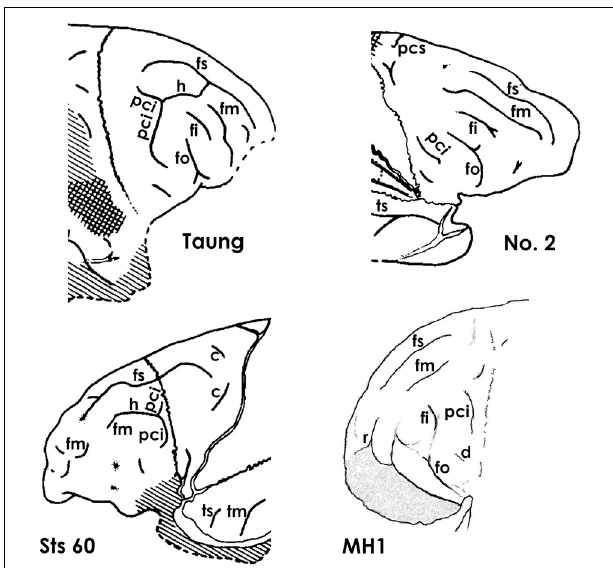
FIGURE 5 | The superior and middle frontal sulcus in Australopithecus endocasts. The middle frontal sulcus ( fm ) of MH1 ( Australopithecus sediba ) is identified here because (1) of its relationship to r (not identified by Carlson et al., 2011), (2) it does not appear to have been derived from (or proximal to) pci (which fi always is, Connolly, 1950), and (3) it courses approximately in the middle of the prefrontal cortex (hence its name). Taung, No. 2, and Sts 60 are endocasts from Australopithecus africanus . Note that all four australopithecines have separate branches of fm , which are rare in ape brains but typical of human brains, and that, in all four, fm is lateral to a long superior frontal sulcus ( fs ). Identifications of sulci: tm , middle temporal; ts , superior temporal; see legend to Figure 4 for other sulcal abbreviations. All illustrations except for MH1 are reproduced from Falk (1980). The identification of fi in Taung and No. 2 departs from Falk’s (1980, 2009) earlier identification of that sulcus as r , but agrees with those of Dart (1929) and Schepers (1946). The line drawing for MH1 is based on the unlabeled photograph of the MH1 endocast from Carlson et al. (2011), reproduced on the left side of Figure 6 . Compare the identifications for MH1 provided here with those of Carlson et al. reproduced on the right side of Figure 6 .